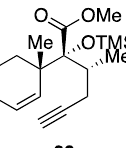
Figure 1. Structures of marrubiin and related natural products.